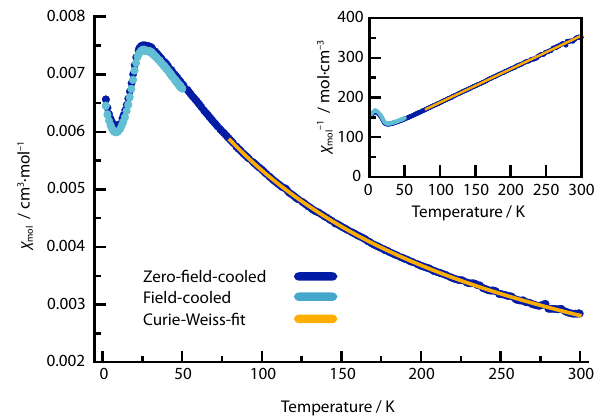
Fig. 2 Temperature dependent molar susceptibility χ mol of Ca 4 FeN 4 . Zero- fi eld cooled and fi eld cooled data are shown. The Curie – Weiss fi t was performed for the temperature range of 80 to 300 K. The inset shows that inverse molar susceptibility χ mol − 1 varies linearly above 75 K, highlighting that a single dominant Curie – Weiss paramagnetic phase is